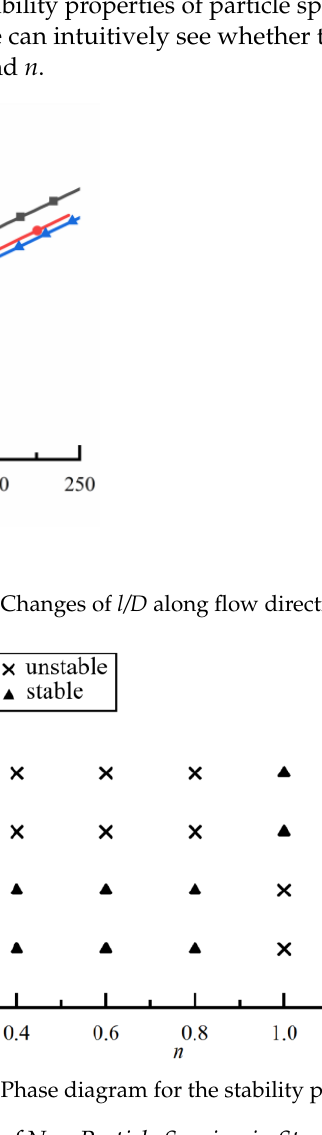
Figure 12. Phase diagram for the stability properties of particle spacing under different β and n .